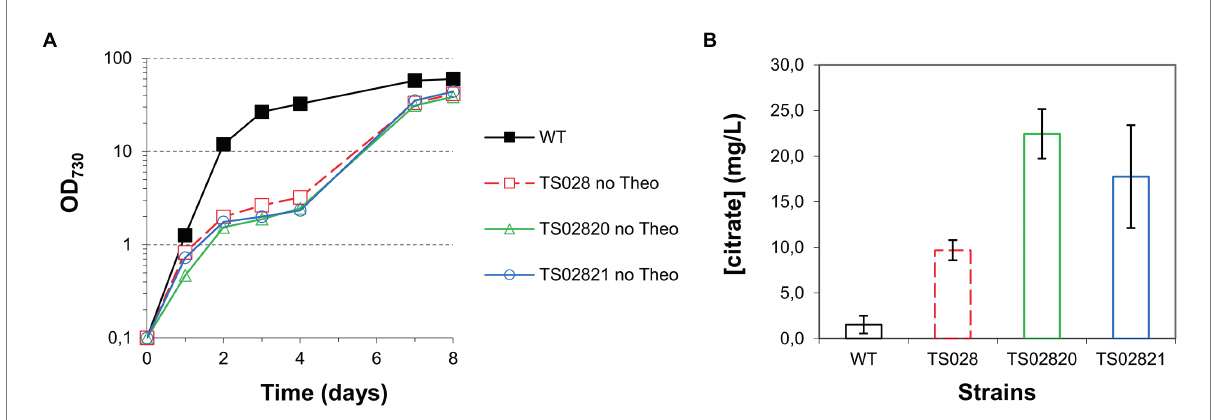
FIGURE 4 Growth curves and citrate quantification for first and second generation strains with acnB gene control. (A) Growth curves (in MAD, 1.5% CO 2 , high light). (B) Citrate quantification in medium at day